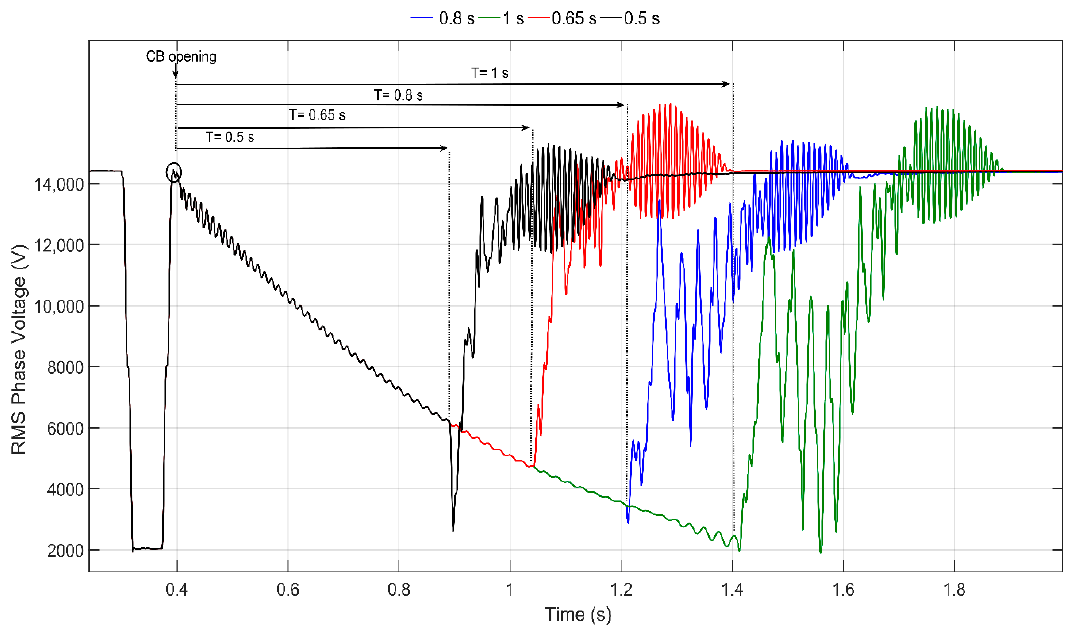
Figure 10. Voltage sag duration for the four simulated reclosing times.